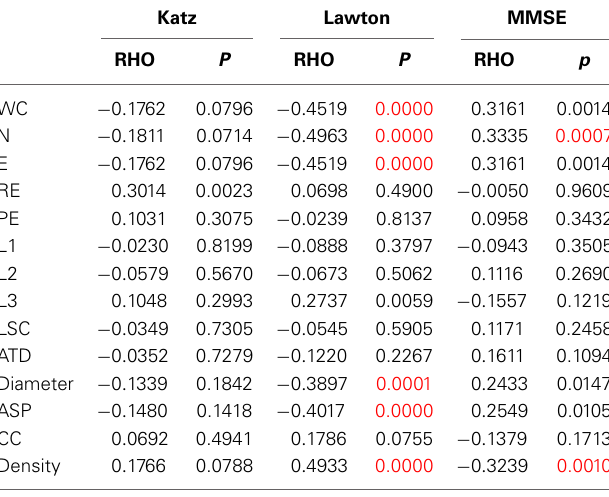
Table 4 | Spearman correlation (RHO and p -values) between SGA scores and the Katz, Lawton or MMSE